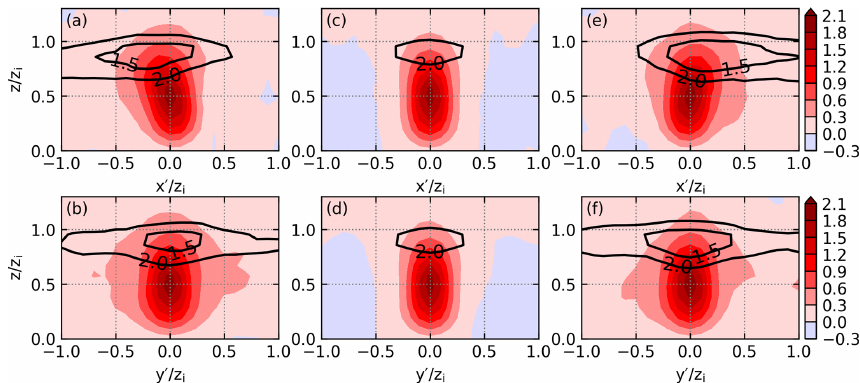
Figure 6. (a) x – z cross section and (b) y – z cross section of the composite left-front thermal averaged from t = 5h 30min to 6h 30min in simulation THF700. The filled contours indicate the non-dimensionalized vertical velocity, and the black contours indicate the dew point depression (K). Panels (c, d) are the same as (a, b) except for the composite intermediate thermal. Panels (e, f) are the same as (a, b) except for the composite right-front thermal.